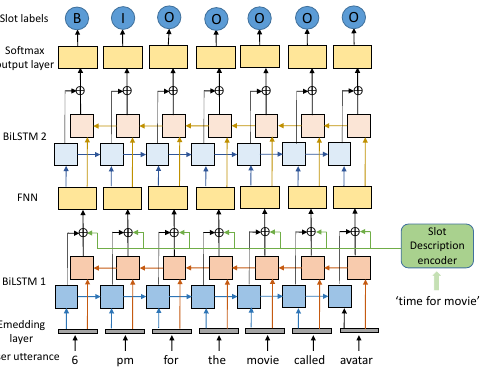
Figure 3. The architecture of the concept Tagging (CT) model [12].